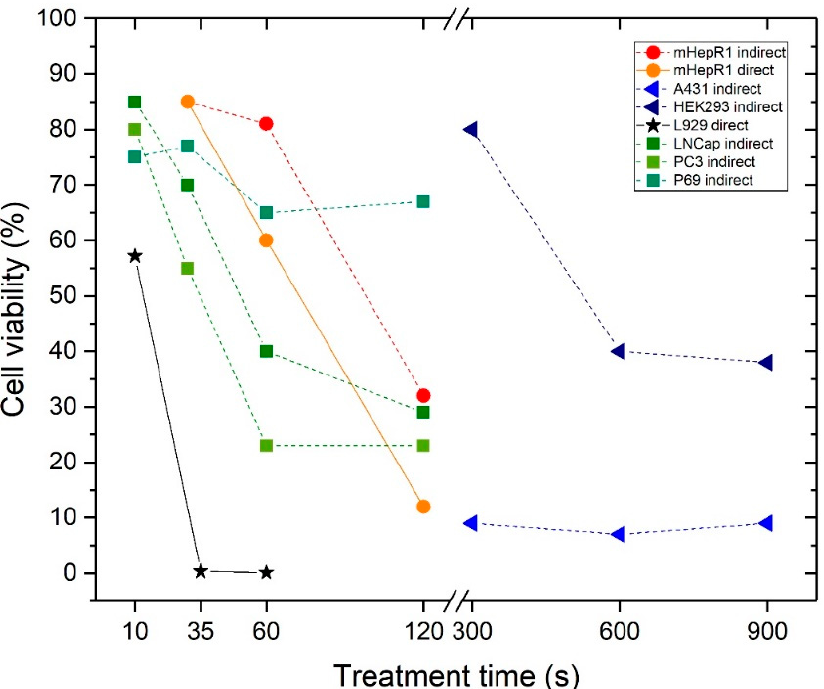
Figure 7. Comparison with other plasma sources: percentage of cell viability to direct (flat line) or indirect (dashed line) plasma treatment. Symbols represent different studies, so the circle is [16], the triangle is [7], the square is [5] and the star represents our system.